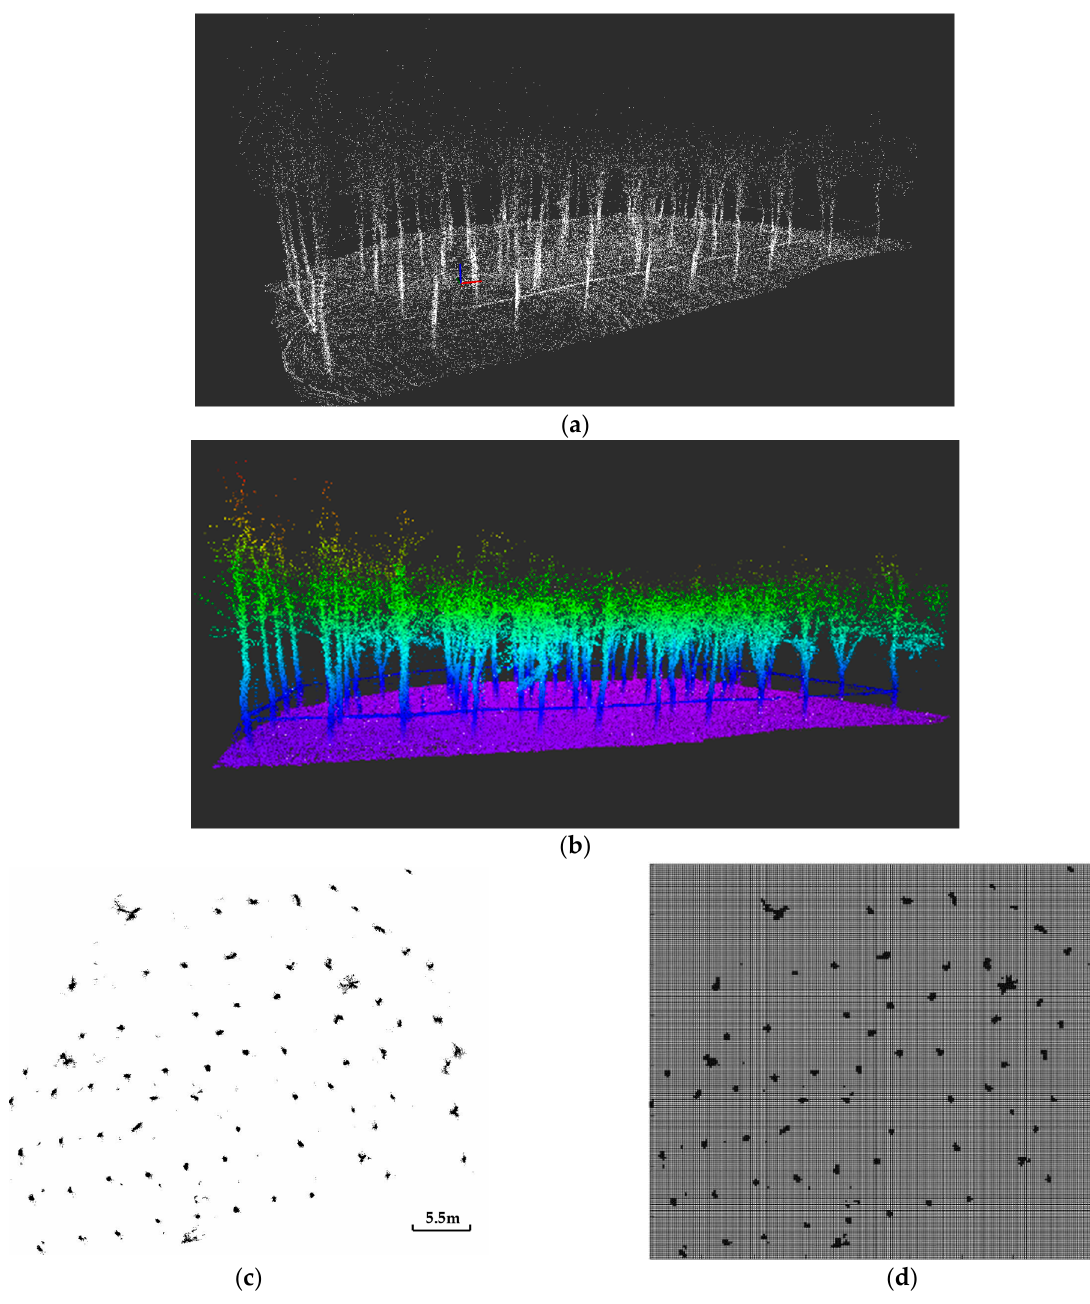
Figure 4. Acquisition and processing process of actual plantation forest map: ( a ) three-dimensional point cloud map of the plantation forest; ( b ) Octomap of the plantation forest; ( c ) grid map of the two-dimensional projection surface of the plantation forest; and ( d ) two-dimensional projection map of the plantation forest after re-rasterization.